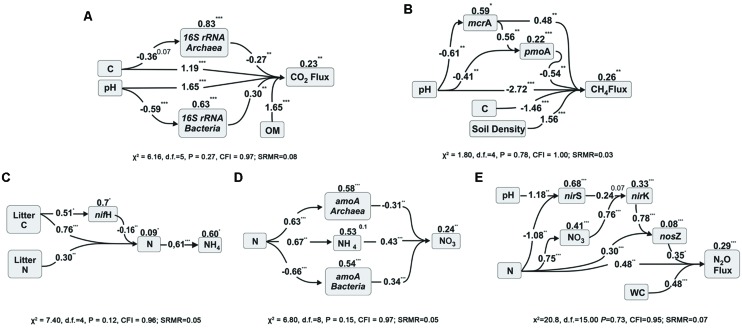
Path analysis diagrams for microbial gene abundances and CO2 fluxes (A); for methane dynamics (B); and for N-cycle related processes, NH4+ prediction (C), NO3- prediction (D) and N2O fluxes (E). The diagrams show the relationships among the selected variables and the influence of soil chemical factors in soils across land use types in Southern Amazonia in the middle of the wet season (for more information please see the Methods section). The numbers listed within arrows are standardized path coefficients (∗P < 0.05, ∗∗P < 0.01, ∗∗∗P < 0.001, or x P < x). The numbers on the top of the variable boxes represent unexplained variation (1 – R2) which represents the effect of unmeasured variables and measurement error. The litter C and N data are from Lammel et al. (2015).